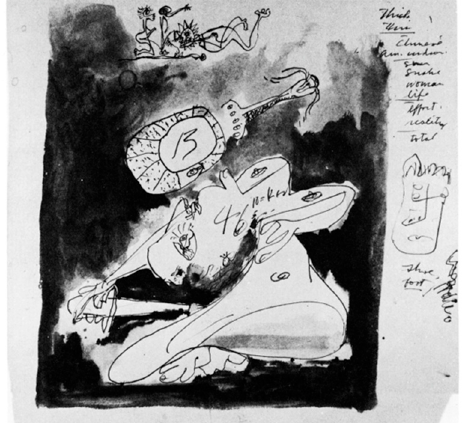
Figure 14. Jackson Pollock, Untitled , CR 704, ca. 1943, ink and touches of red gouache on brown paper, 12 1/2 × 13 in. (31.7 × 33 cm). Gift of the artist to B. H. Friedman. Present location unknown. © 2022 The Pollock-Krasner Foundation/Artists Rights Society (ARS), New York. A number following CR refers to the number designated to each of Pollock’s works in O’Connor and Thaw